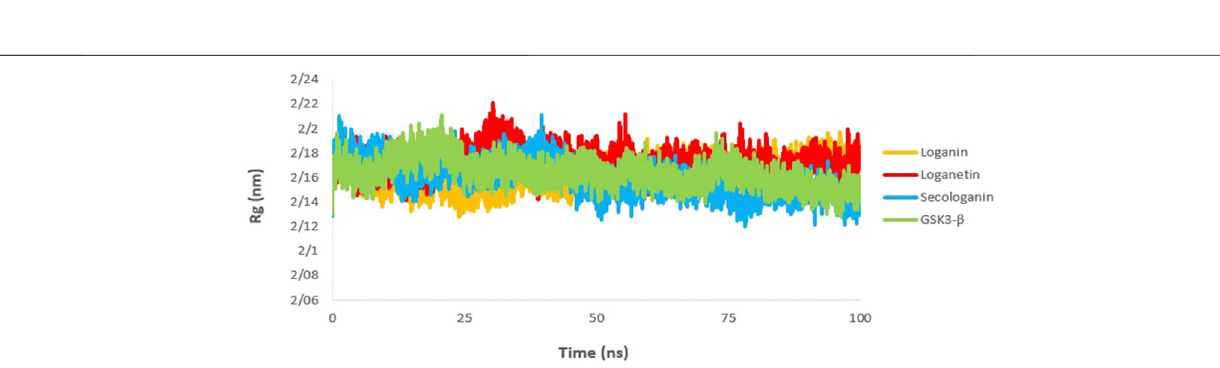
Frontiers in Chemistry |